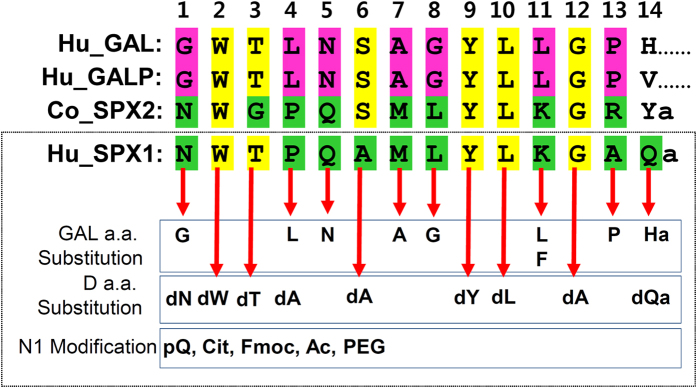
Sequence alignment of human (Hu) GAL, GALP, SPX1, and coelacanth (Co) SPX2.Conserved residues in the peptides are indicated in yellow. SPX-specific residues are in green, while GAL-specific residues are highlighted in violet. The residues in human SPX1 were changed as indicated.